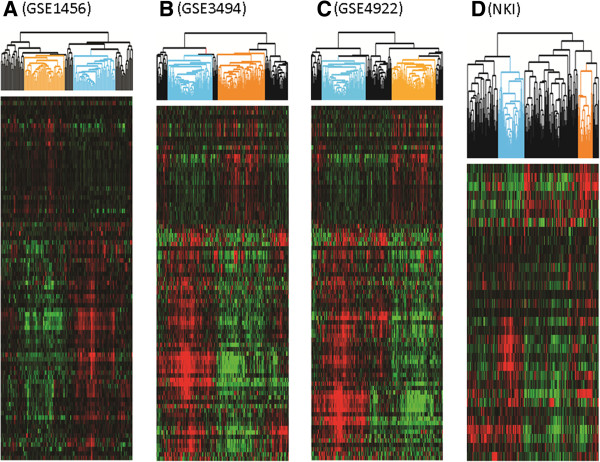
Hierarchical clustering of four breast cancer datasets by FOTS/EF core gene sets. Within the heatmap, red represents higher expression levels, green represents lower expression levels, and black represents mean expression levels. Sample clusters designated with Orange and Blue trees are FOTS + breast cancers and EF + breast cancers in GSE1456 (A), GSE3494 (B), GSE4922 (C) and NKI dataset (D).